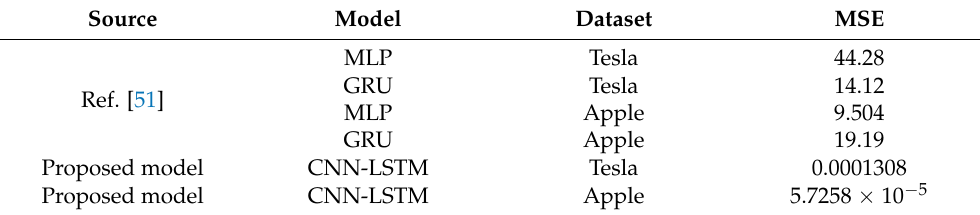
Table 6. Prediction results of the proposed CNN-LSTM system compared to the results of